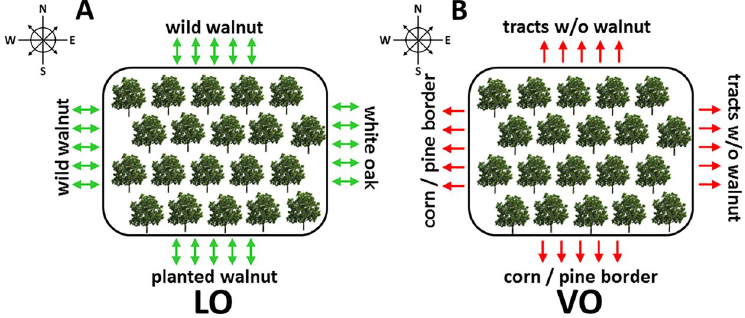
Fig 1. Schematic diagram of (A) Lugar (LO) and (B) Vallonia (VO) orchards. w/o =